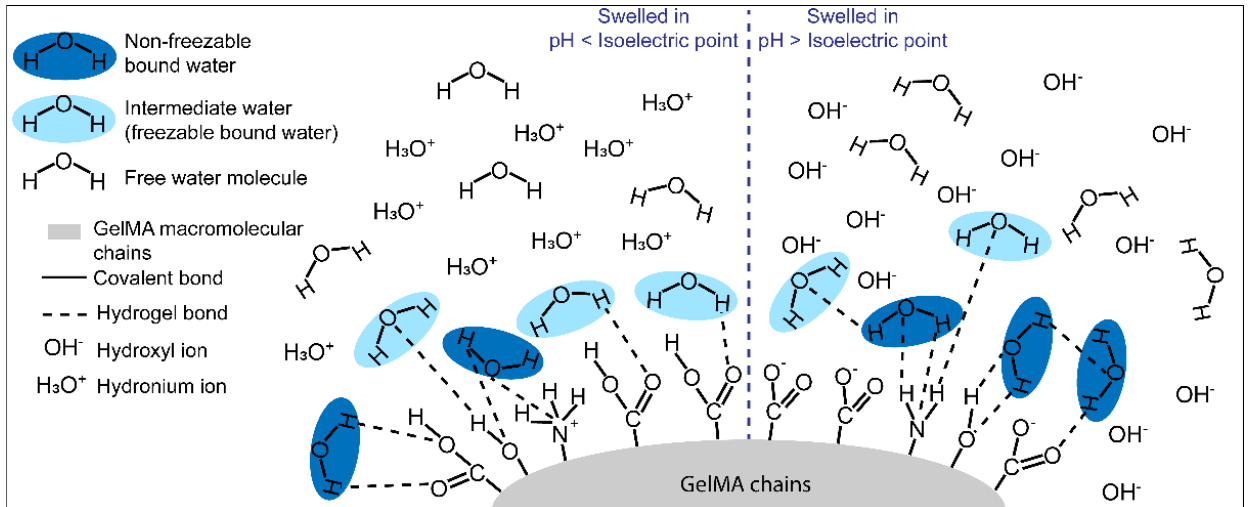
Figure 10. Graphic illustration of the water content in GelMA hydrogels swelled at different pH. W f , W nfb and free water molecules are presented with the same conventions as in Figure 3. On the left, when the pH of the swelling media is below the GelMA isoelectric point, the amine functional groups are protonated, thus providing an overall positive charge at the surface of GelMA. Because the amine groups are in the minority compared to the carboxylic acid groups, the charge and effect on the water content and states is minimal. On the right, when the pH of the swelling media is above the GelMA isoelectric point, the carboxylic functional groups tend to be deprotonated, giving an overall negative charge to the hydrogel, making it more hydrophilic and thus imparting a higher water content and higher W nfb